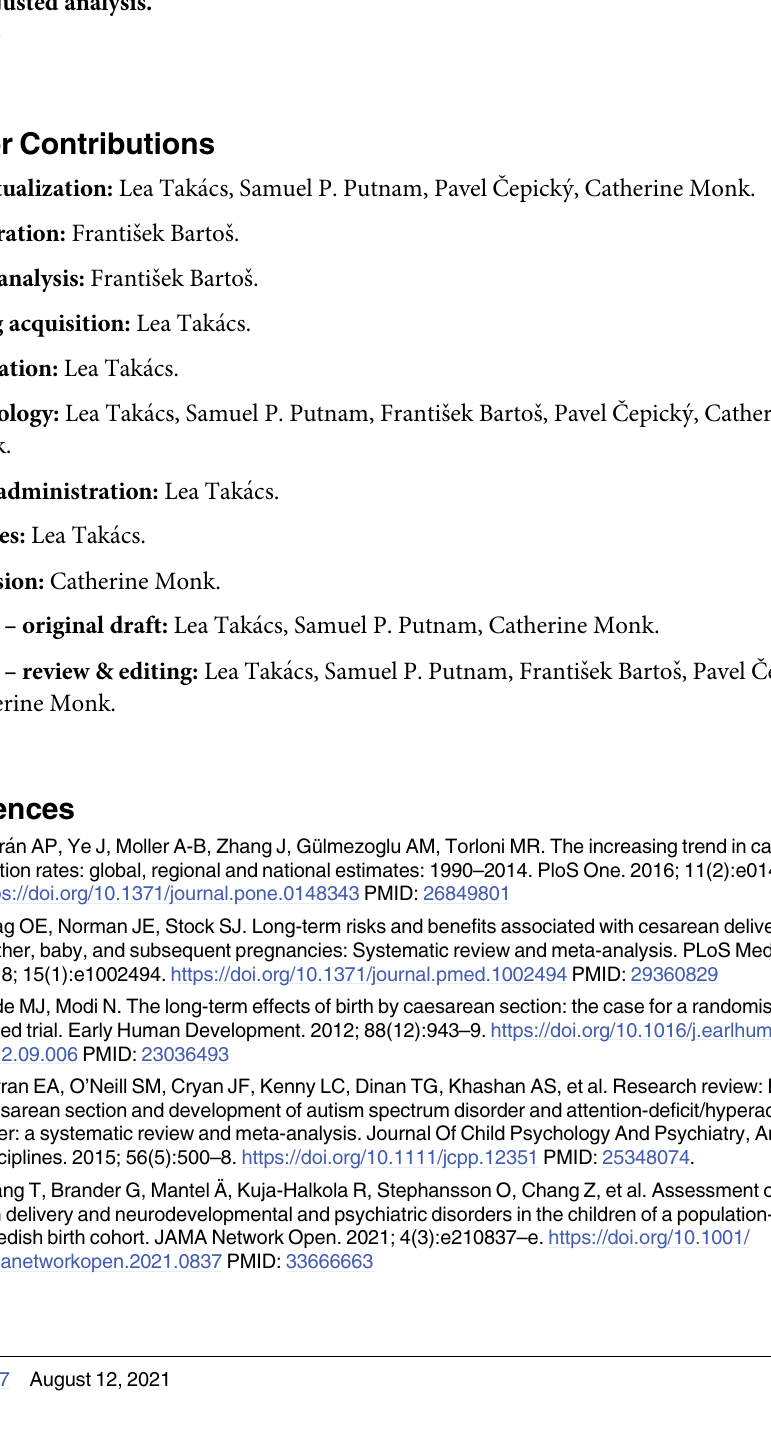
S1 Table. Differences between the women who dropped-out of the study from T2 to T3 and those who did not. S2 Table. Association between the mode of delivery and infant temperament—Unadjusted analyses. S3 Table. Association between indications for Caesarean section and infant temperament —Unadjusted